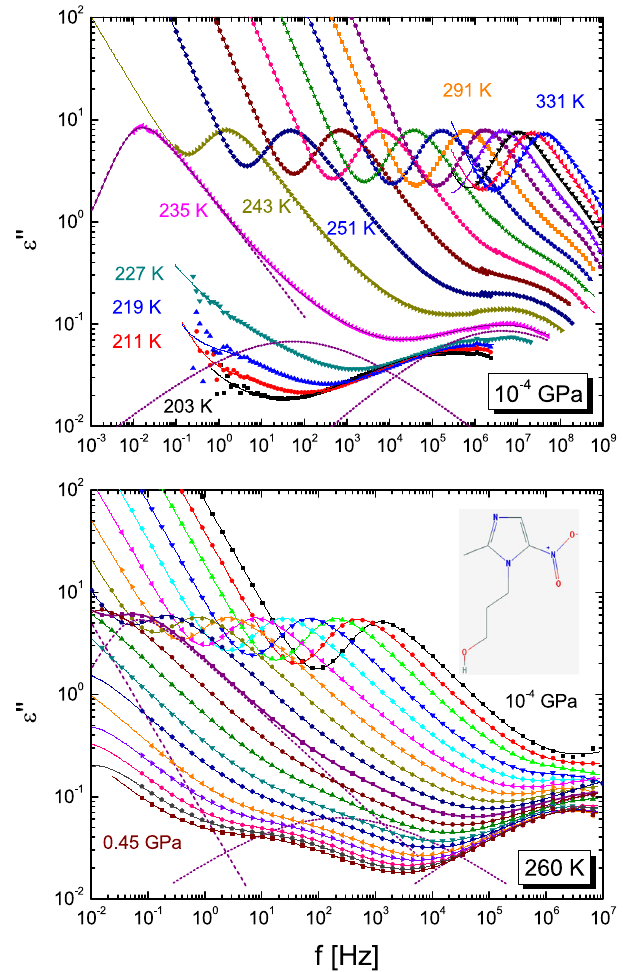
Figure 1. Dielectric loss spectra of supercooled TDZ for several temperatures at normal pressure (upper panel) and for pressures between normal pressure and 0.45 GPa every 25 MPa at the constant temperature of 260 K (lower panel). In both panels, markers are experimental points, continuous lines are fits, and dashed lines represent separate spectral components ( i . e ., the conductivity term and a separate peak for each relaxation). For clarity, the fit components are only shown for the spectrum acquired at 235 K in the upper panel, and for the spectrum at 0.225 GPa in the lower panel. Inset to the lower panel: molecular structure of the TDZ